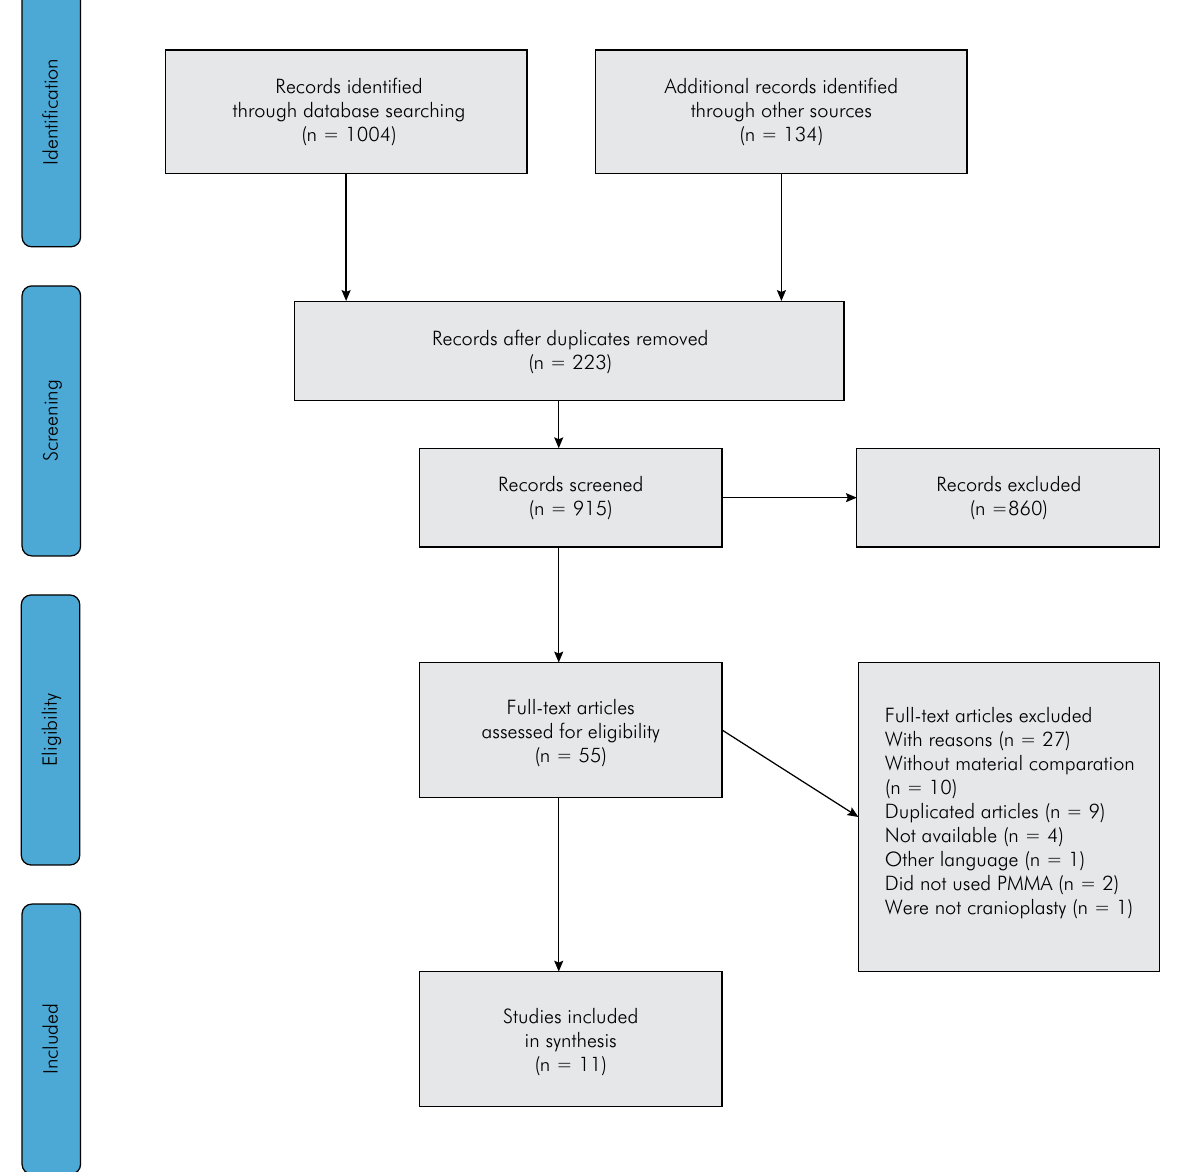
Figure 1. Flowchart of literature